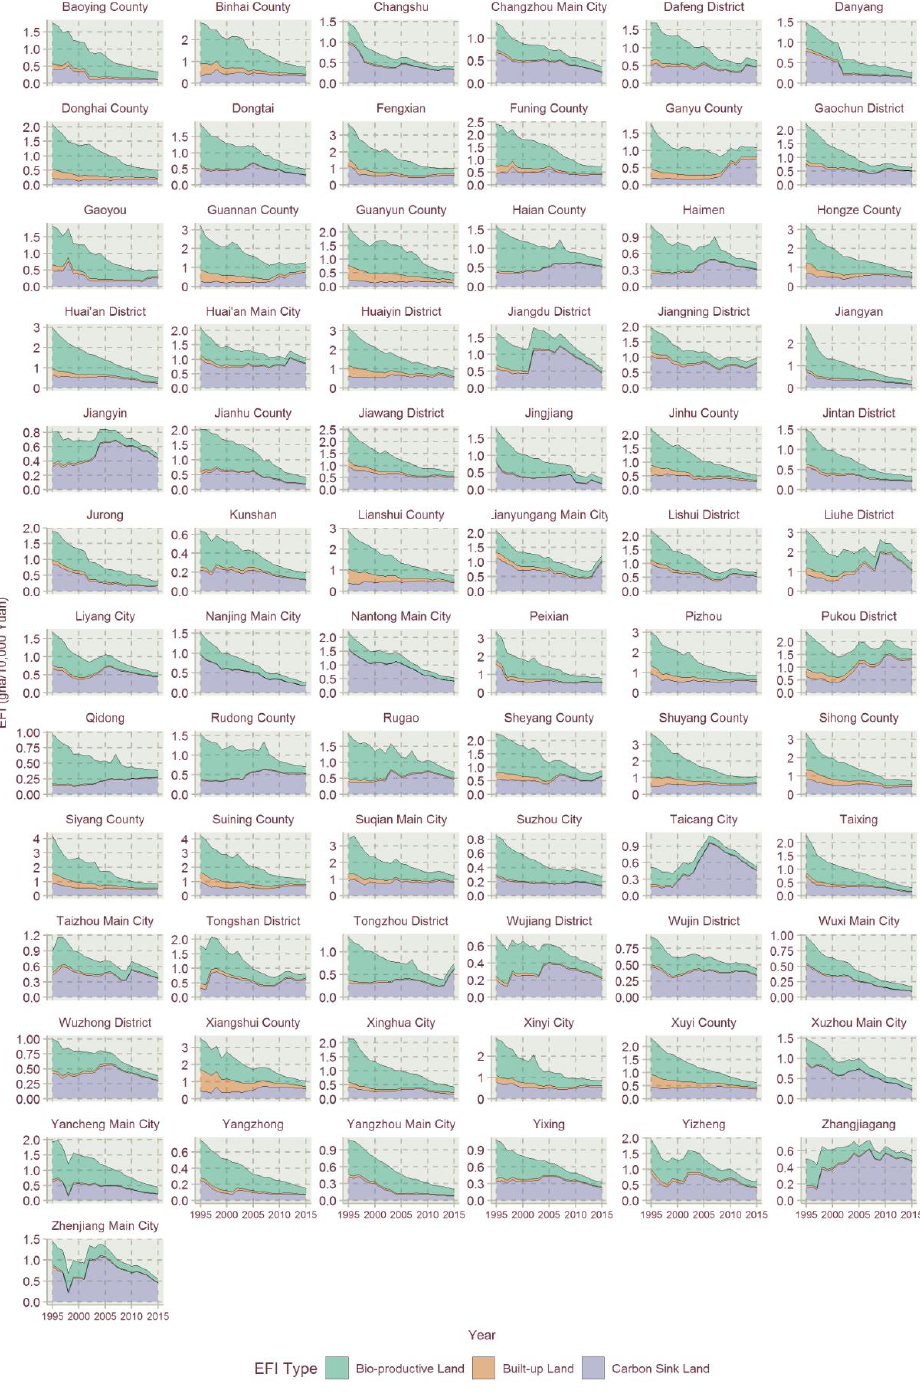
Figure 3. Temporal changes in EFIs of Jiangsu Province for 1995 – 2015, categorized by bio-productive land, built-up land and carbon sink land.